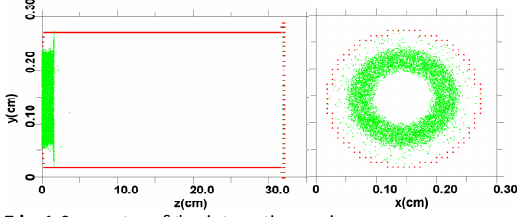
Fig. 1 Geometry of the interaction region.